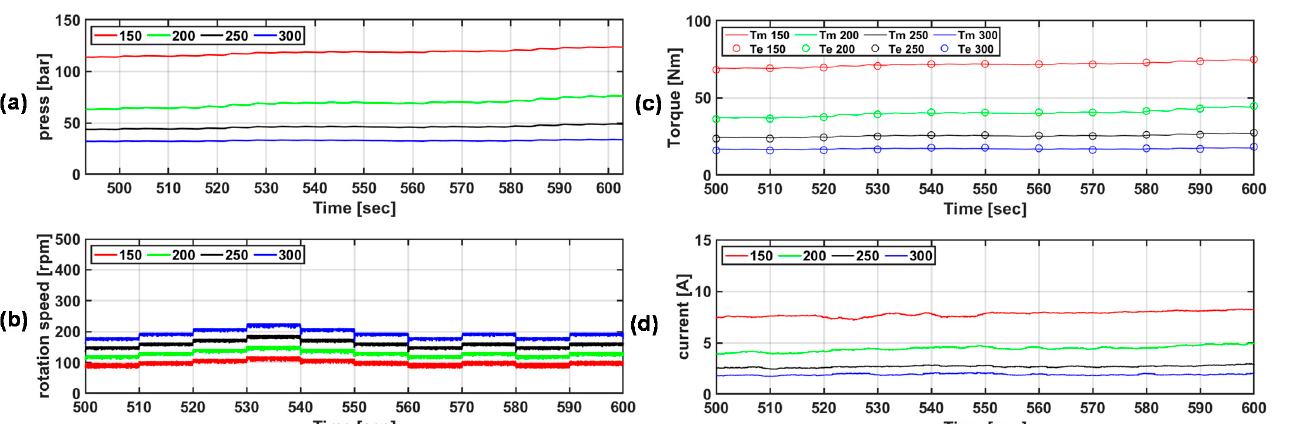
Figure 17. ( a ) Float pitch angle, ( b ) Fpto , ( c ) float velocity, and ( d ) generated flow rate according to the initial rpm of the speed control algorithm under irregular wave conditions ( H s = 0.75 m, T p = 4.75 s) (legend indicates initial rpm).